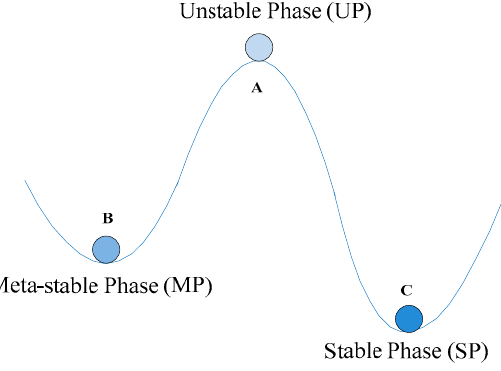
Figure 1. Three possible positions of elements in a system.